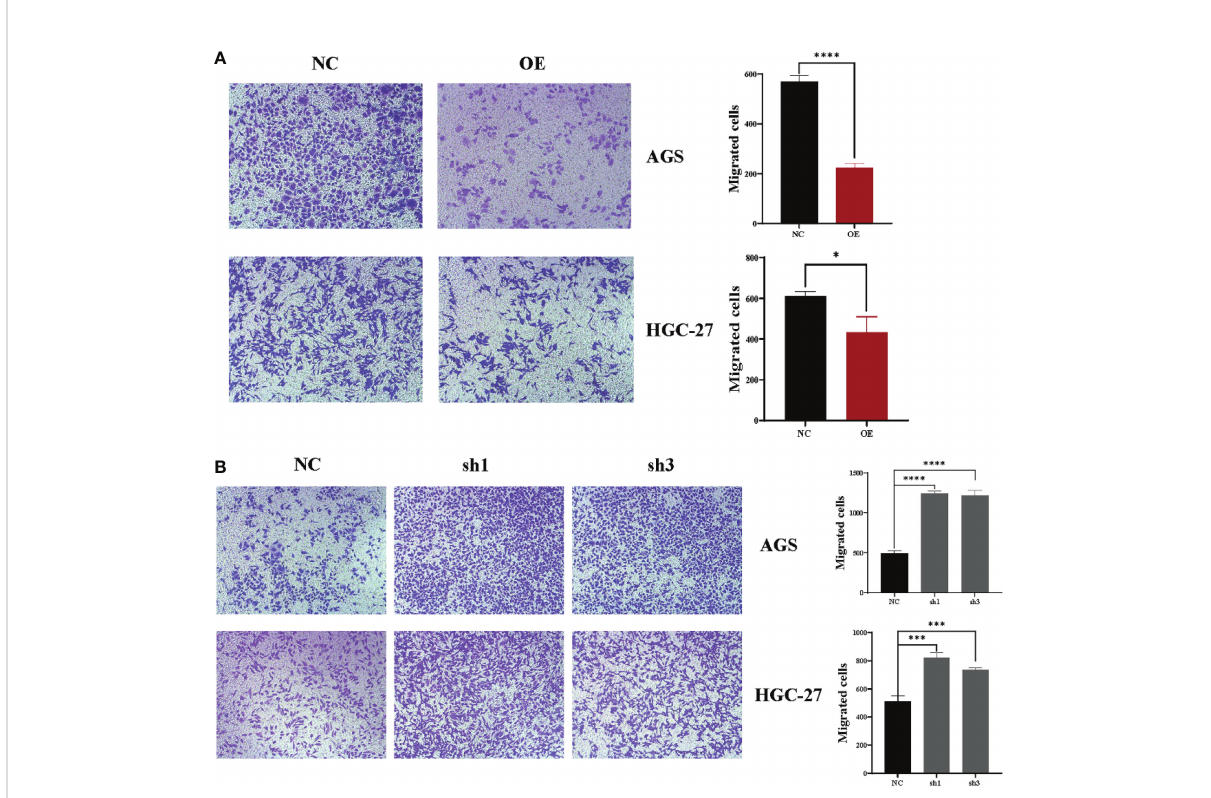
FIGURE 2 Changes in the migration ability of gastric cancer cells after upregulation and downregulation of hsa_circ_0061276 in a Transwell migration assay. (A) Representative results of the effect of hsa_circ_0061276 overexpression on the migration ability of cells (left, 10×) and the statistical analysis results (right). OE, overexpression plasmid; NC, negative control plasmid. * p < 0.05, **** p < 0.0001; n = 3. (B) Representative results of the effect of hsa_circ_0061276 downregulation on the migration ability (left, 10×) and the statistical analysis results (right). NC, negative control plasmid; sh1 and sh3, short hairpin RNA plasmids; *** p < 0.001, **** p < 0.0001; n = 3. Independent samples t -test (two-tailed) for A and